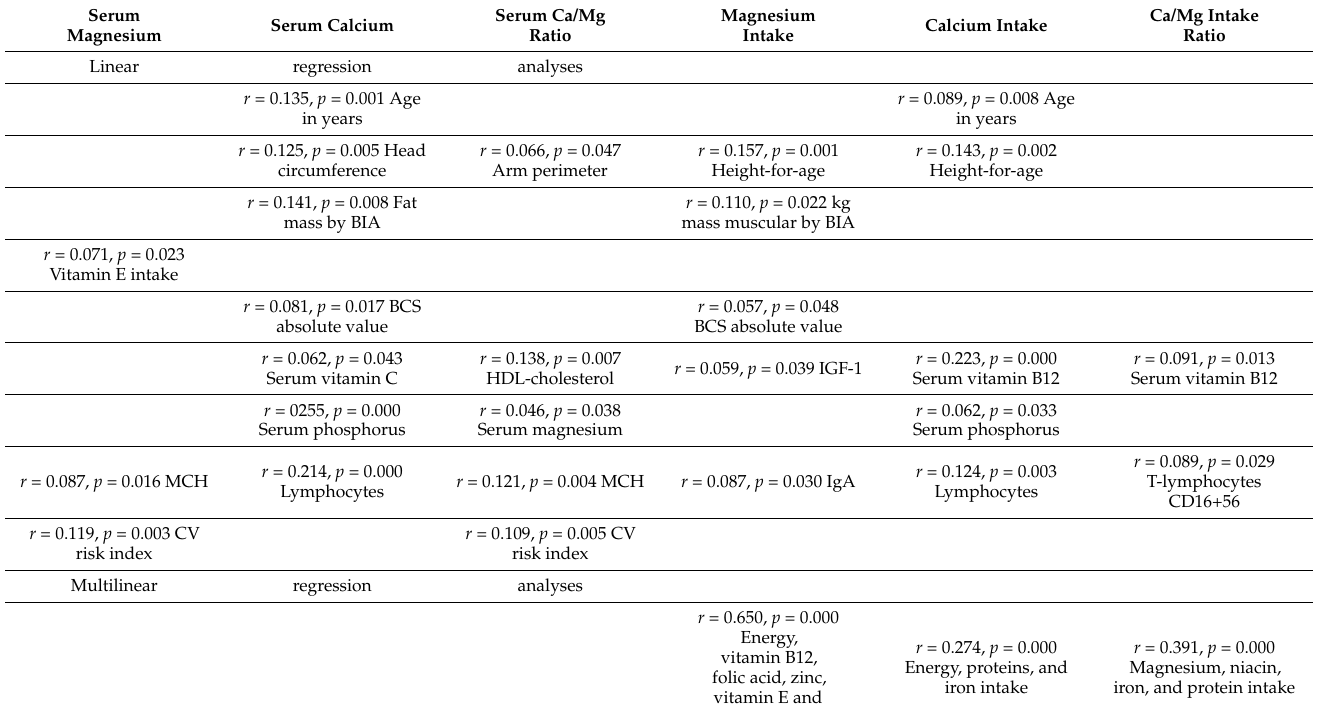
Table 8. Regression analysis between serum level and dietary intake of magnesium (Mg) and calcium (Ca), serum and dietary Ca/Mg ratios, and nutritional parameters ( n =